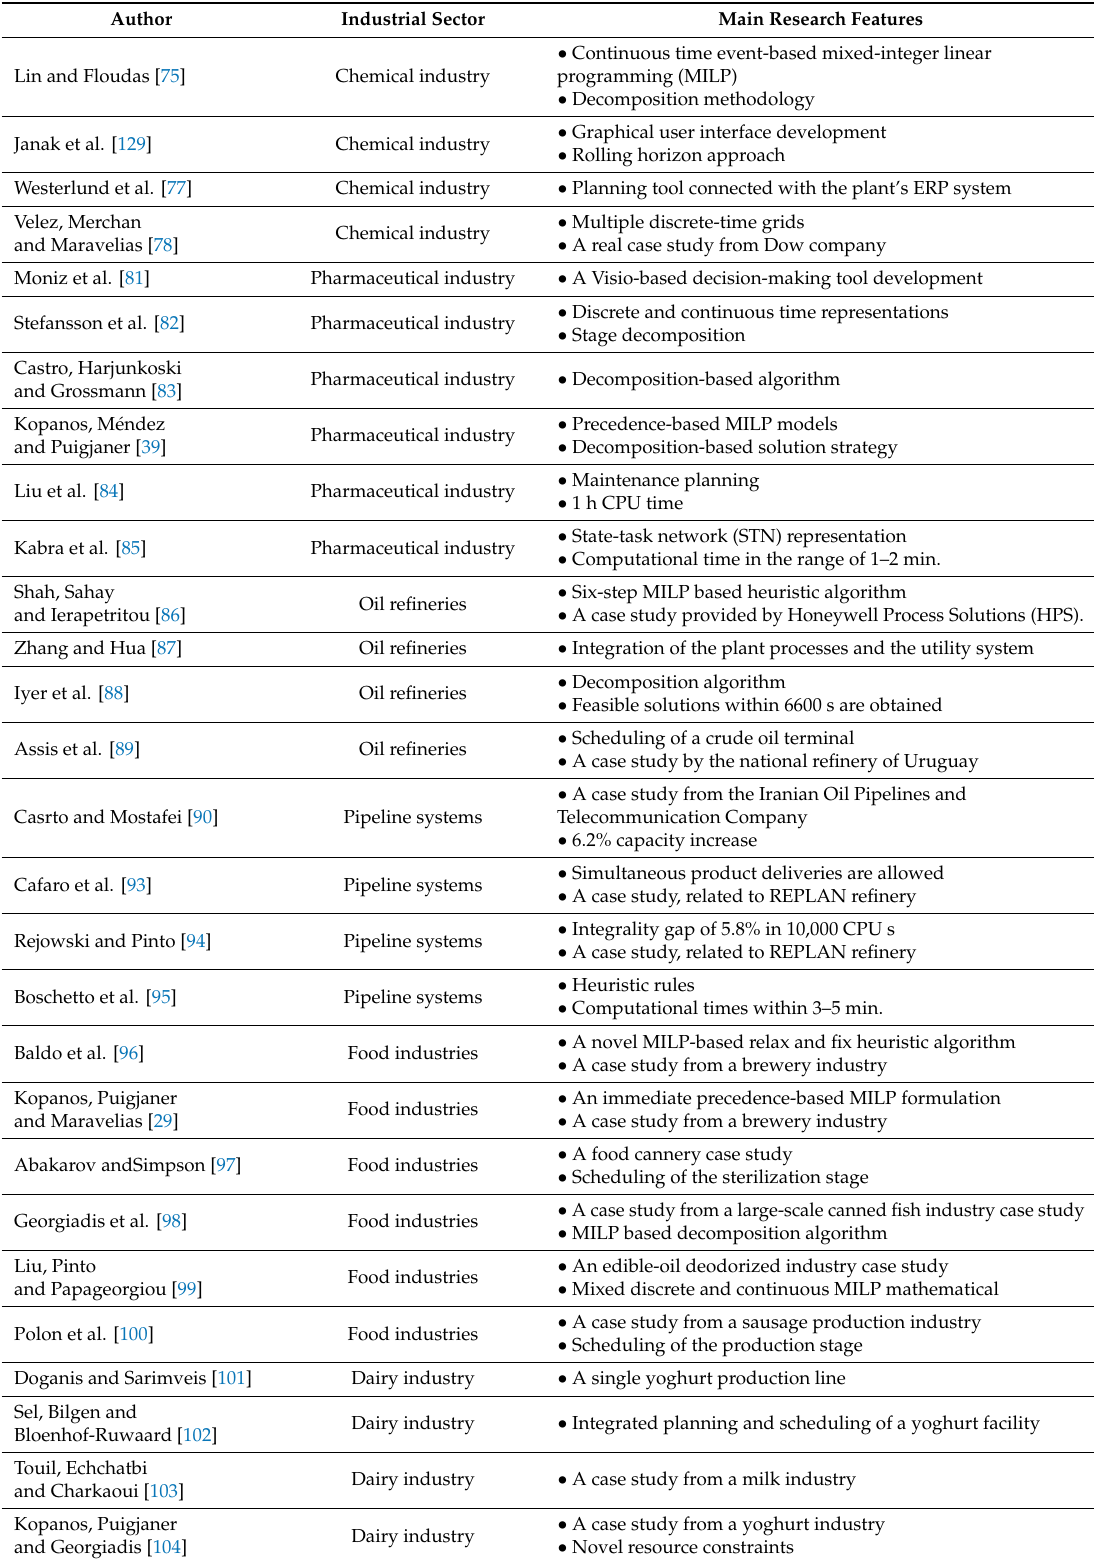
Table 1. Summary of the industrial applications using optimization-based scheduling